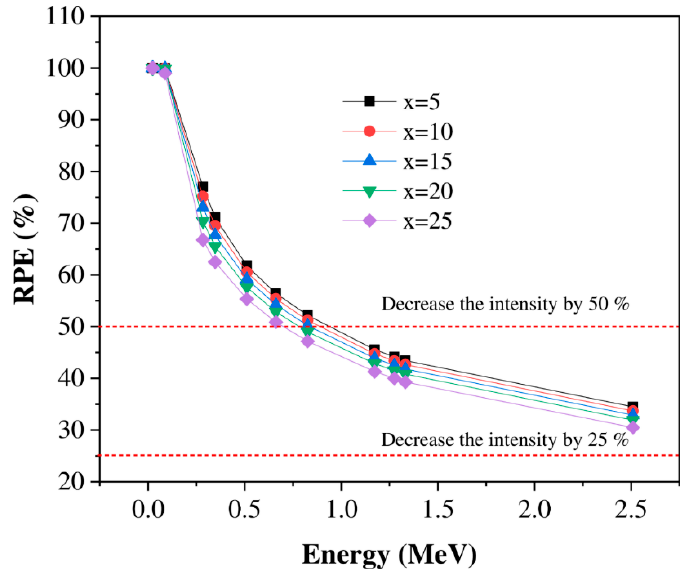
Figure 7. Variation in the investigated glasses’ radiation protection efficiency (RPE) versus the photon energy.